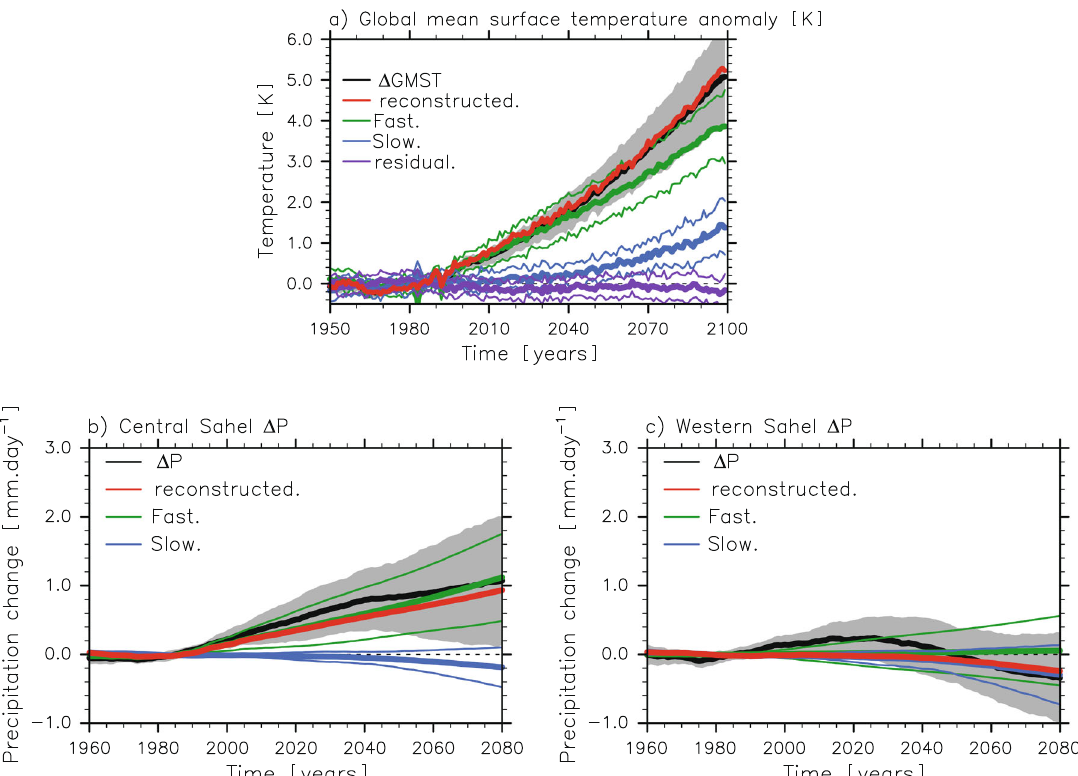
Fig. 2 Contribution of the two timescales responses to climate change. a Multi model mean contribution of the fast (green) and slow (blue) response to the global mean surface temperature warming (K) in SSP585 (black) (thick line). Residual is given by the purple line and the reconstruction (fast + slow) by the red line. Grey shading (thin lines) indicates the inter model spread, de fi ned from each model, for the SSP585 response (fast, slow and residual responses). b Multi model mean change in central Sahel precipitation (mm day − 1 ) for SSP585 response (black), fast (green), slow (blue) and reconstructed (red) responses. c as in b but for western Sahel and eastern Atlantic Ocean. High- frequency variability anomalies are fi ltered-out with a 21-year running